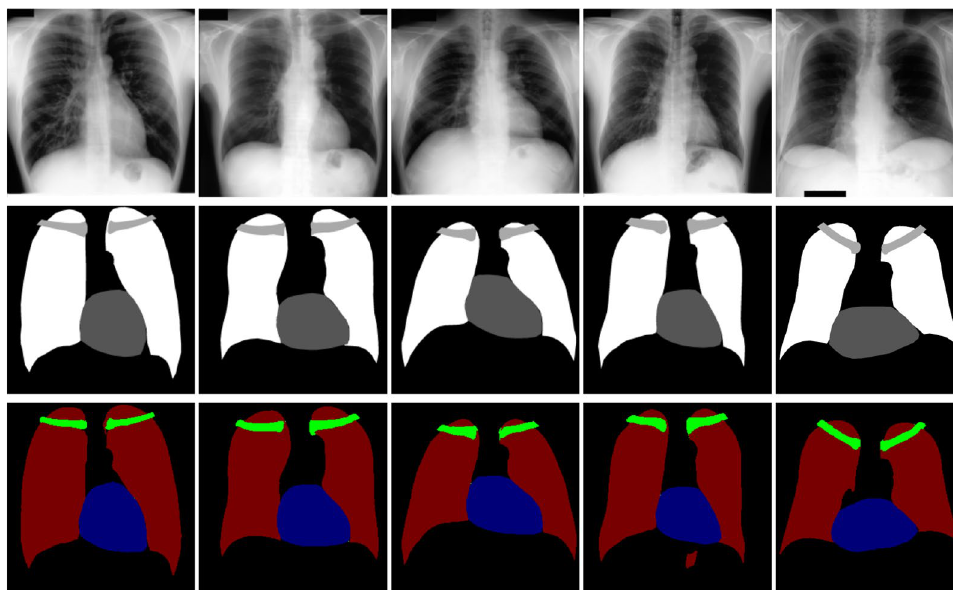
Figure 4. Qualitative results of our proposed method on a test sample from the JSRT dataset. From top to bottom: inputs, groundtruth labels, and the segmentation